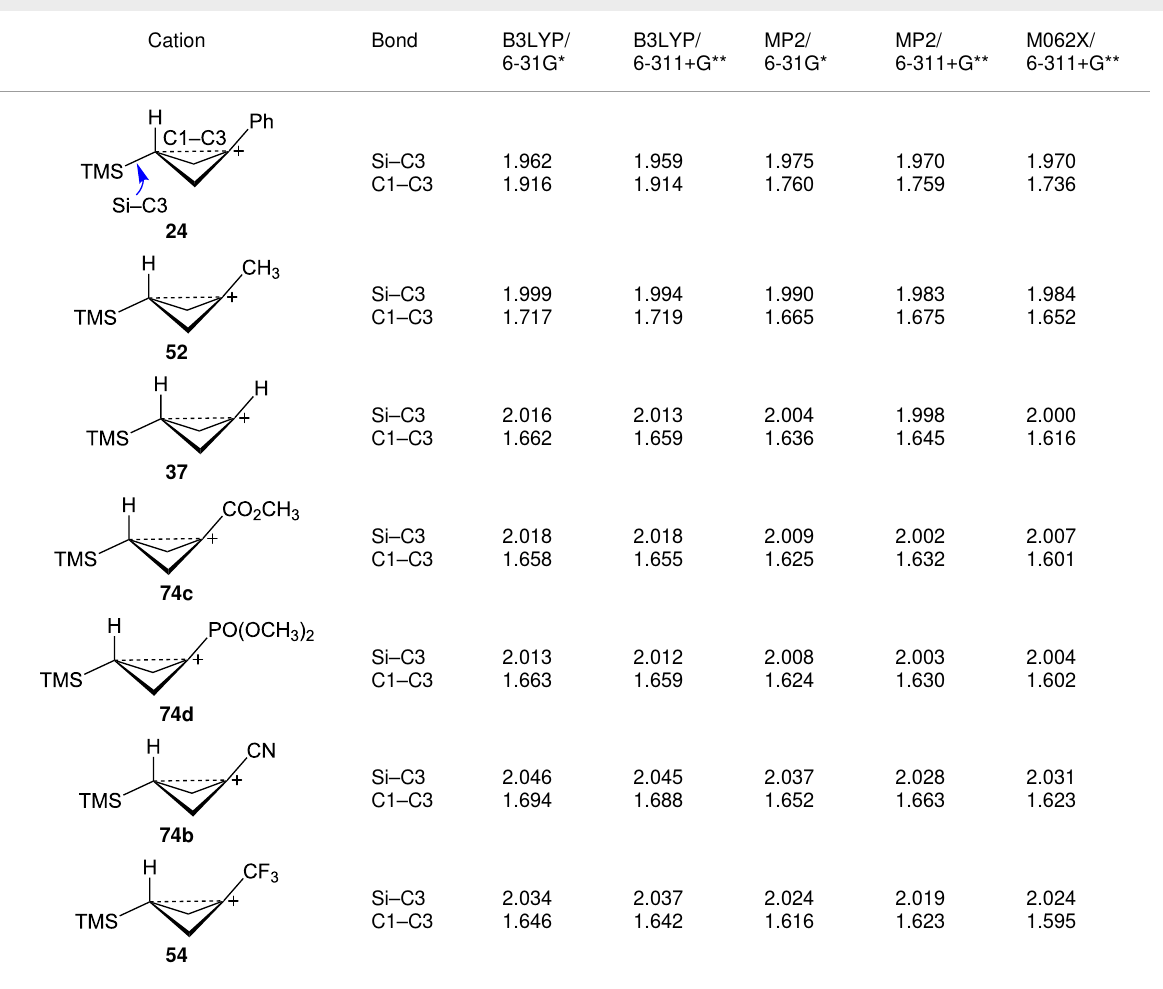
Table 3: Calculated bond lengths (Å) of γ -trimethylsilyl